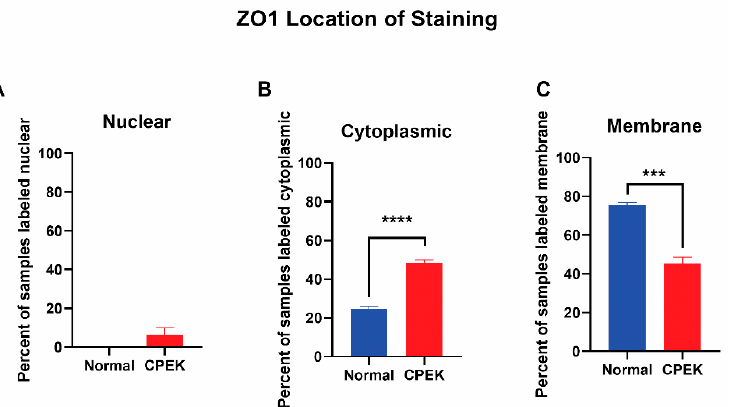
Figure 8. The location of ZO-1 staining. Percent shown is the number of observers who labeled staining in each location. ( A ) Nuclear staining was not significantly different between normal and CPEK, though normal cells had 0% of samples labeled as nuclear while CPEK had 6.19% labeled as nuclear. ( B ) Statistical analysis by Welch unequal variance t -test showed normal vs. CPEK cytoplasmic staining was significantly different ( p < 0.0001), with CPEK cells having more cytoplasmic staining. ( C ) Normal vs. CPEK membrane staining was significantly different ( p = 0.0002), with normal cells having more membrane staining. **** indicates a significance of less than 0.0001 while *** indicates a significance higher than 0.0001.